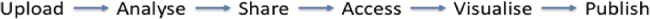
Example CDH user workflow.